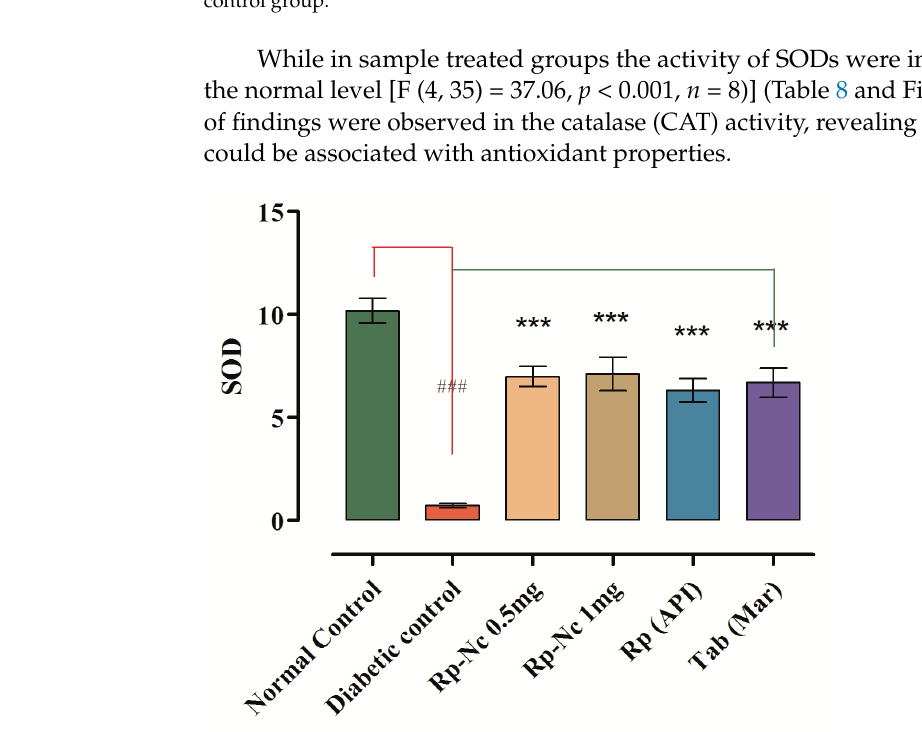
Figure 9. Photomicrographs of microsection of kidney of rat ( A ) control group showing the normal histological structure of renal parenchyma and bowman capsule, ( B ) diabetic group showing focal necrosis of epithelial lining renal tubules with architecture disturbance, ( C , D ) Rp ‐ Nc 0.5 mg and 1 mg treated groups showing slight hydropic degeneration along restoring histological structure of hepatic lobules, Rp ‐ Nc 1 mg treated group showing slight congestion along restoration of normal histological structure of histological structure of renal parenchyma (H & E scale bar 25 μ m). The photomicrograph of liver histopathology from normal control group revealed normal architecture in comparison to mild hydropic degeneration of hepatocytes in dia ‐ betic control group with mild necrosis and infiltration (Figure 10). Administration of